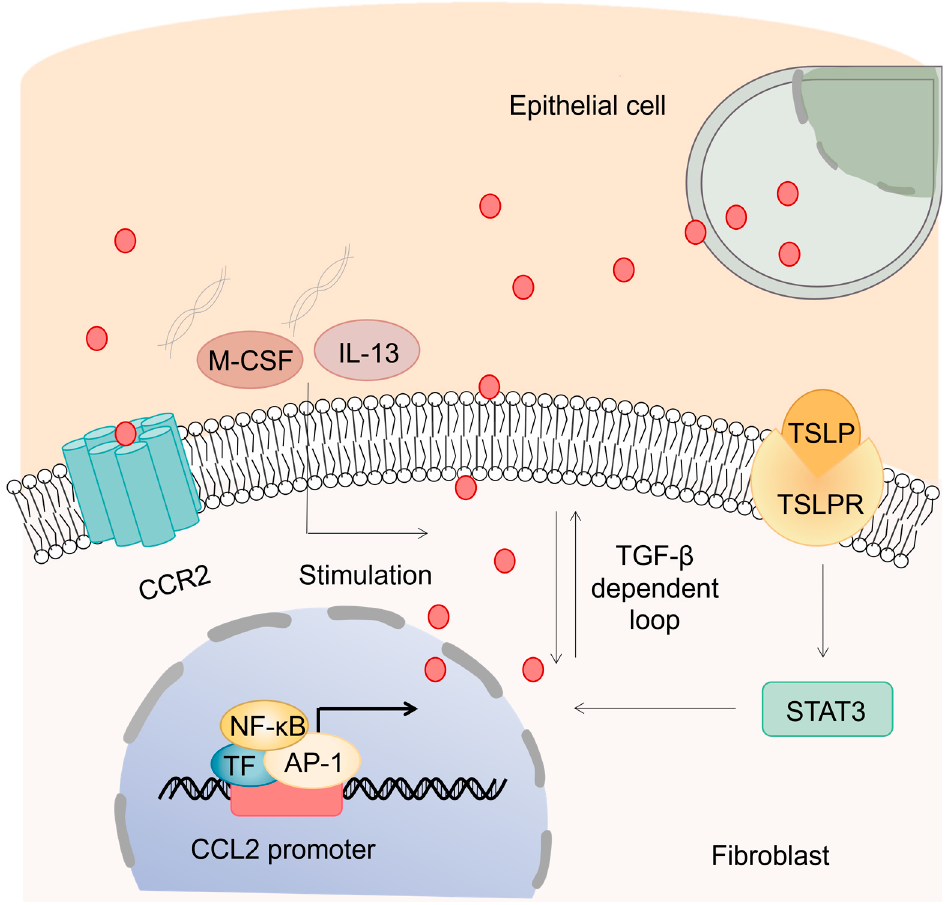
Figure 2. Enhanced CCL2 contributes to myofibroblast activation. CCL2 is mainly secreted by alveolar epithelial cells and pulmonary fibroblasts in IPF. In addition to the enhanced binding of TF to NF- κ B and AP-1 elements in the promoter, the TSLP-TSLPR-STAT3 transduction axis and stimulation of M-CSF, IL-13 or collagen type I can also induce augmentation of CCL2 in fibroblasts. CCL2 stimulates collagen synthesis by interacting with CCR2 and upregulating TGF- β . The profibrotic chemoattractant CCL2 participates in the pathogenesis of IPF by activating fibroblasts and inducing collagen deposition.